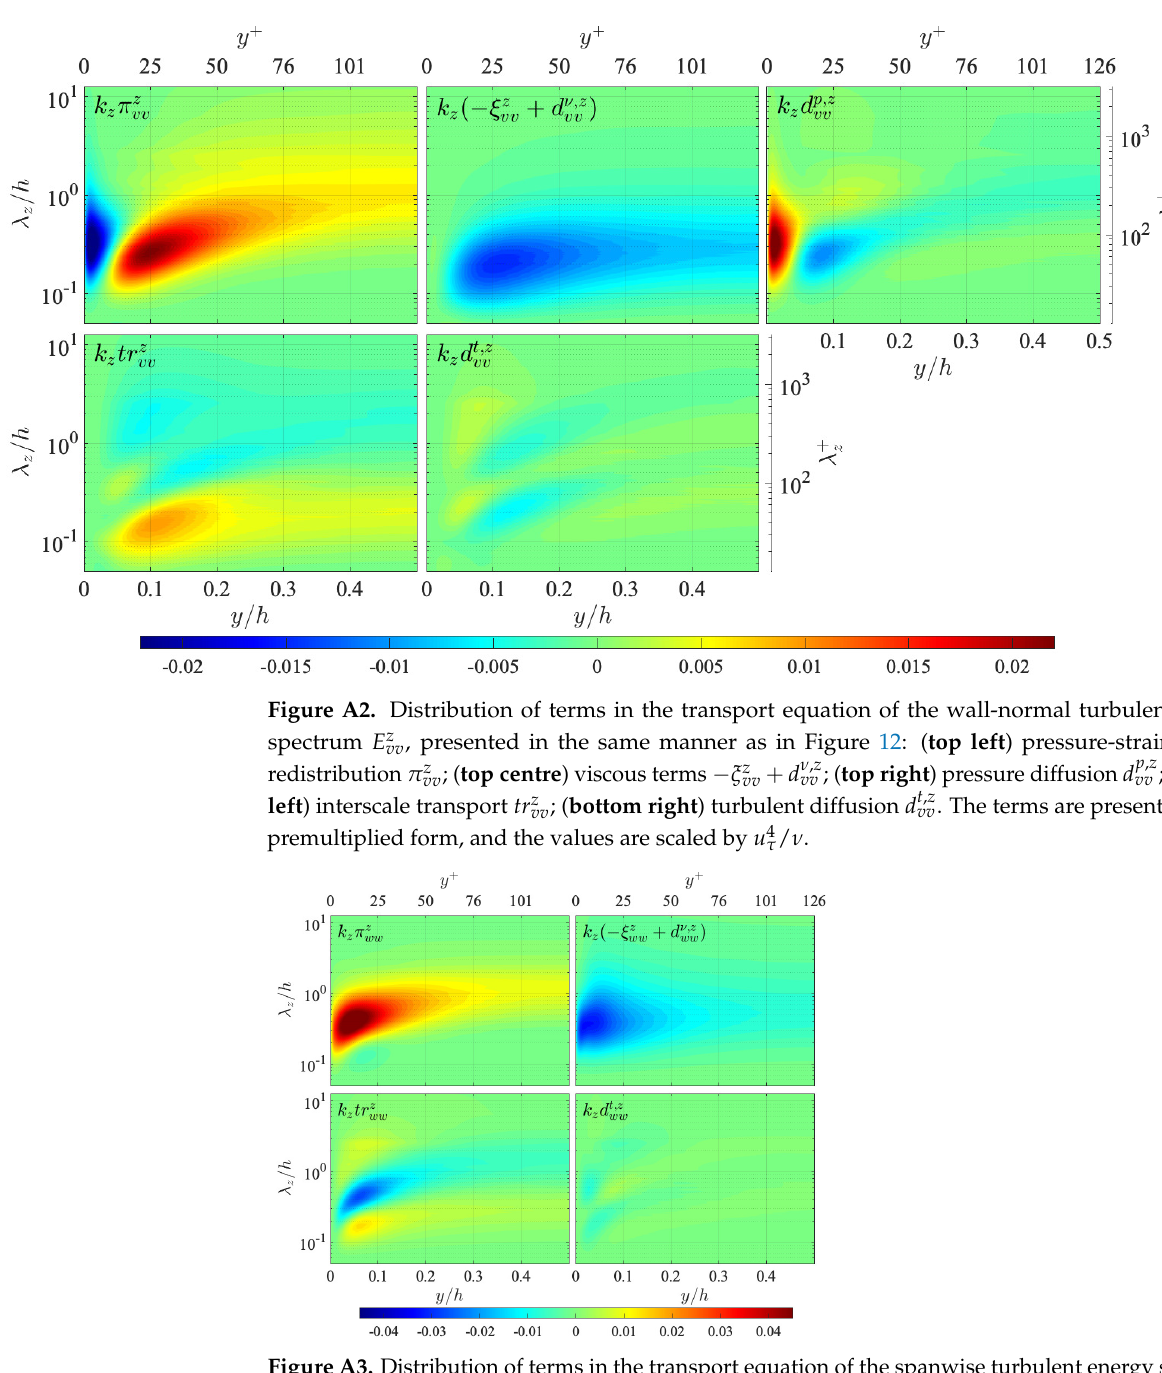
Figure A3. Distribution of terms in the transport equation of the spanwise turbulent energy spectrum E z ww , presented in the same manner as in Figure 12: ( top left ) pressure-strain energy redistribu- tion π z ww ; ( top right ) viscous terms − ξ z ww + d ν , z ww ; ( bottom left ) interscale transport tr z ww ; ( bottom right ) turbulent diffusion d t , z ww . The terms are presented in the premultiplied form, and the values are scaled by u 4 τ / ν